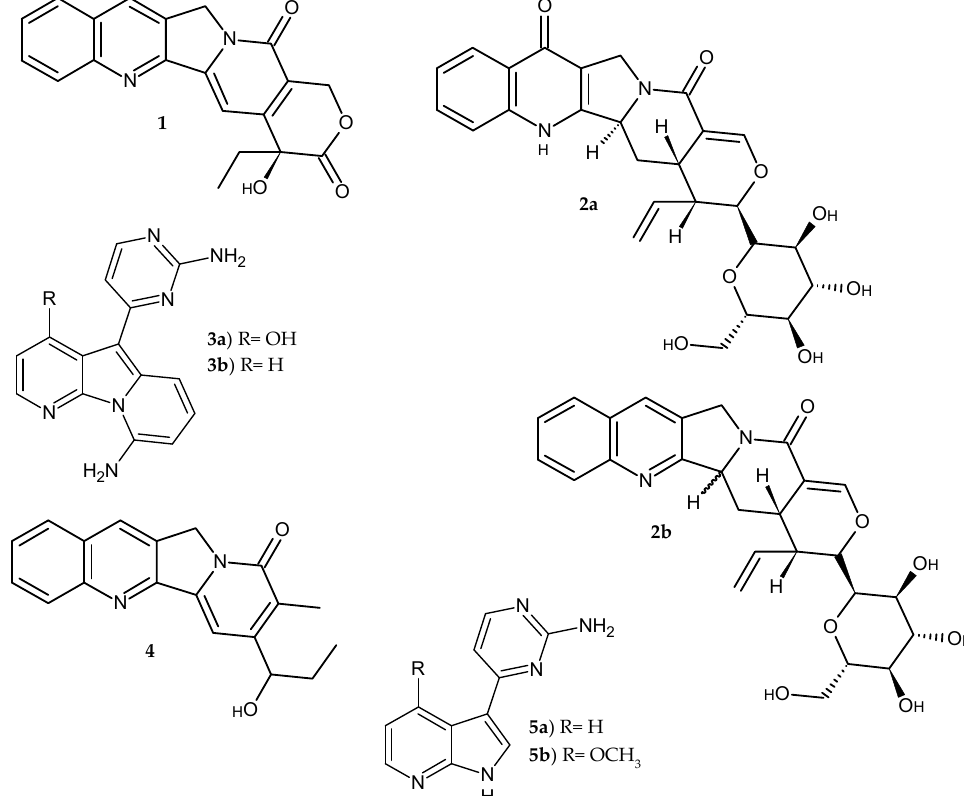
Figure 2. Alkaloids 1–5 containing pyrrolopyridine scaffold.